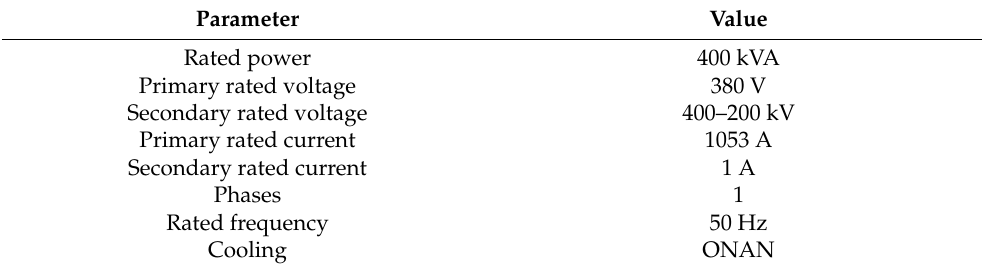
Table 1. The technical specifications of AC high voltage testing equipment.